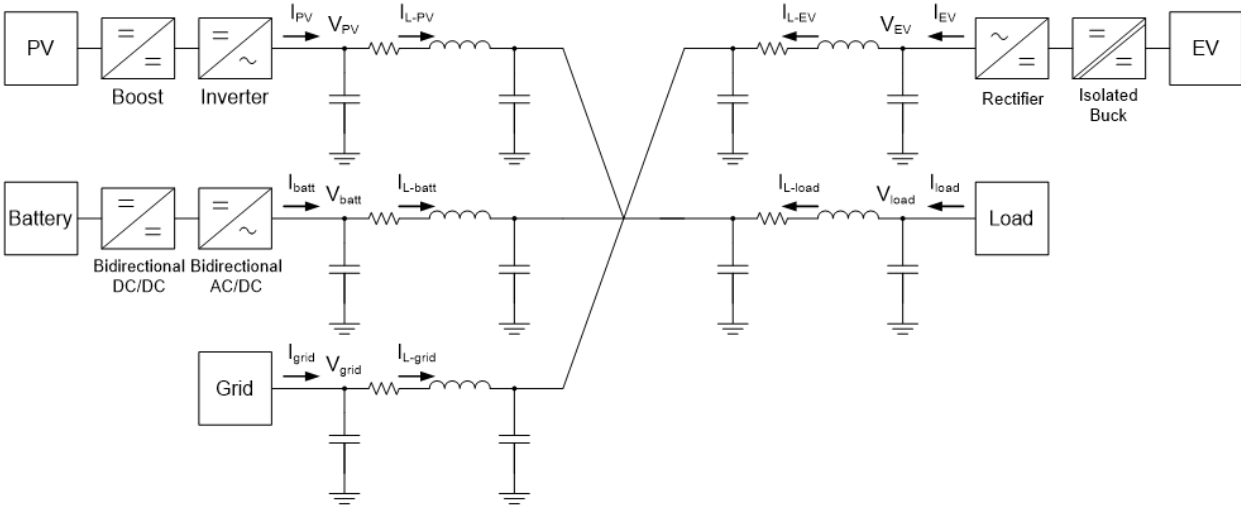
Figure 7. Single line diagram of a AC